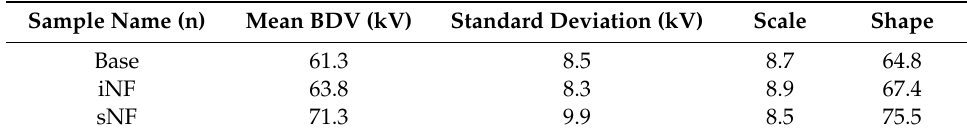
Table 3. Descriptive statistics of the compared samples.